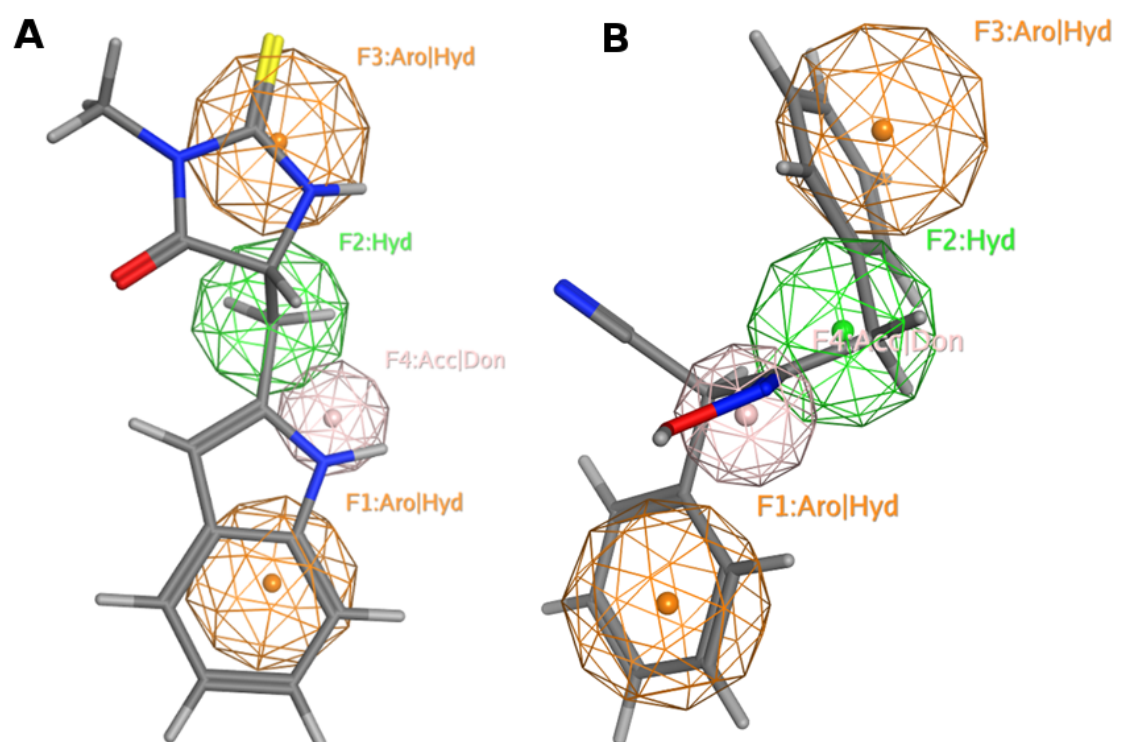
Figure 6. MAO-A pharmacophore model with ( A ) 5-((1H-indol-2-yl)methyl) -3-methyl- 2-thioxo imidazolidin -4-one and ( B ) NSC 38.